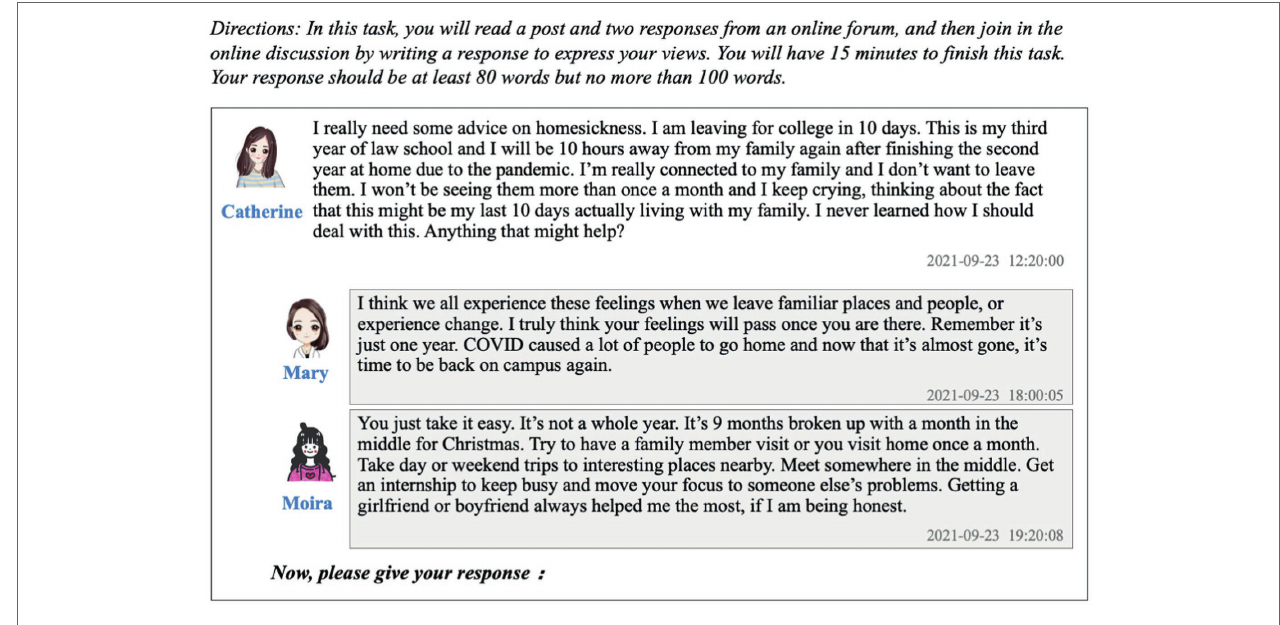
FIGURE 1 | The prompts for the RTFP